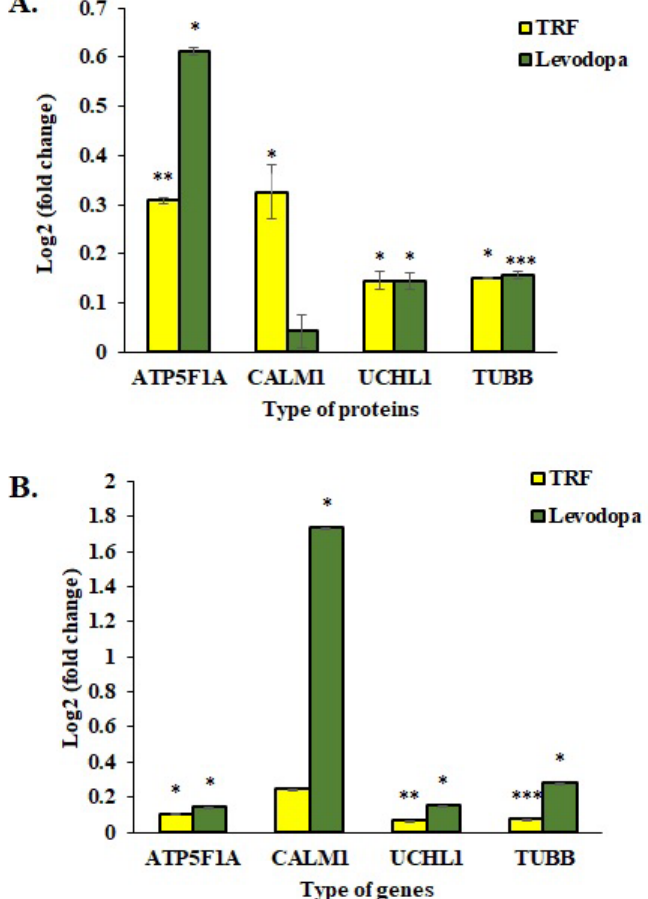
Figure 6. Validation study of mRNA expressions of four selected genes, ATP5F1A, CALM1, UCHL1 and TUBB. ( A ) The log 2 fold change protein expression following TRF and levodopa treatment on diff-neural cells. ( B ) The log 2 fold change values of selected mRNA expression following TRF and levodopa treatment on diff-neural cells. For calculation of p value, the normalized data set from TRF and levodopa treated group were compared against normalized data obtained from untreated control group. The values are expressed as mean ± SEM (n = 3), Significant difference * p < 0.05, ** p < 0.01, *** p < 0.001 compared to untreated control